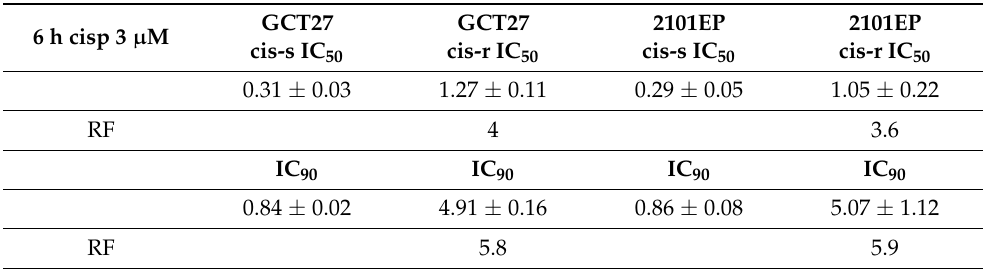
Table 2. Half-maximal inhibitor concentrations (IC 50 ) and 90% of maximal inhibition (IC 90 ) for cisplatin in the indicated cell lines. Data are mean values ± s.d. of at least three independent experiments. RF = resistance